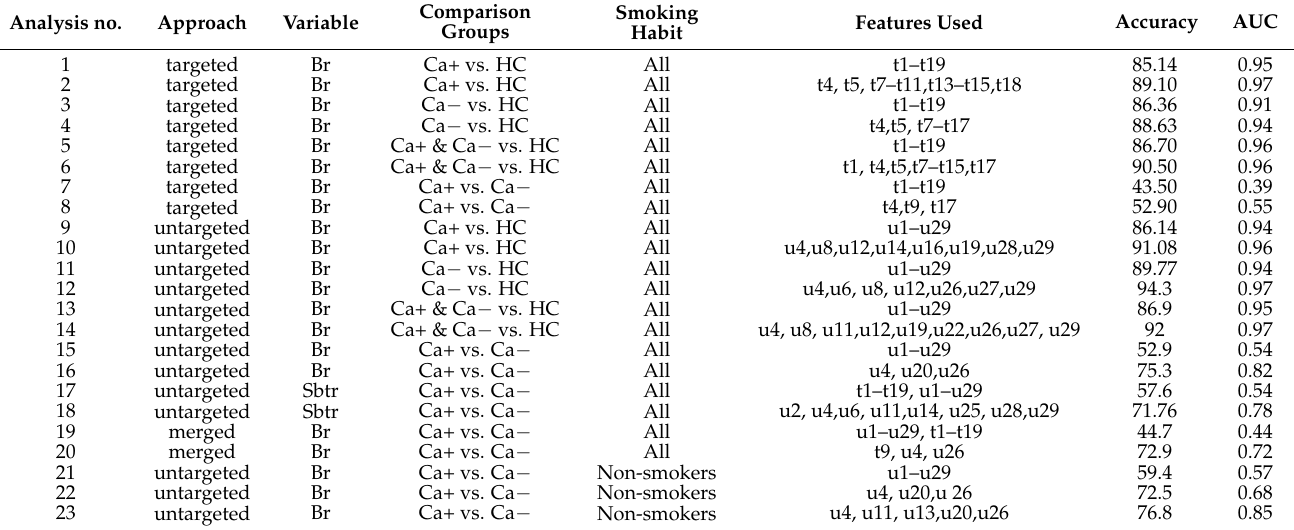
Table 3. Results of machine learning methods (random forest) to estimate the discrimination efficiency of the breath analysis. Analysis no.